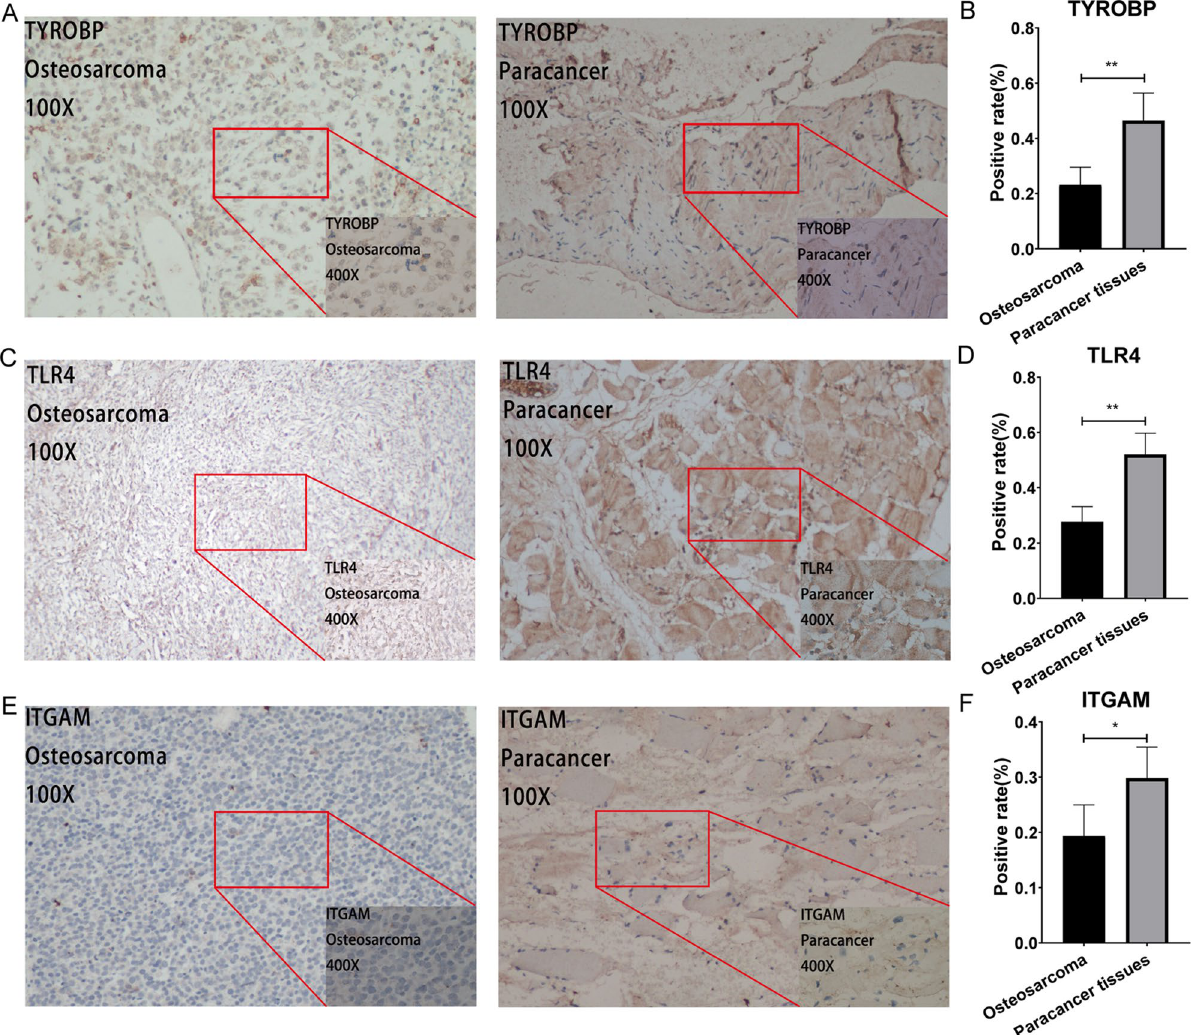
Figure 9. Immunohistochemical plots of the three hub genes associated with prognosis and statistical analysis of the positivity rate. ( A , C , E ) shows the protein expression of each gene in OS and in the paracancer. ( B , D , F ) shows the statistical analysis of the staining positivity rate for each gene in OS and in the paracancer. *Representative P-value < 0.05, **representative P-value <